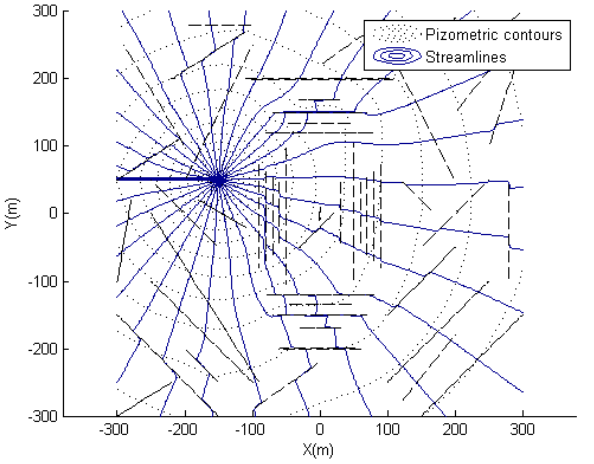
Figure 8. 50 fractures with parameters in Table 3 with a